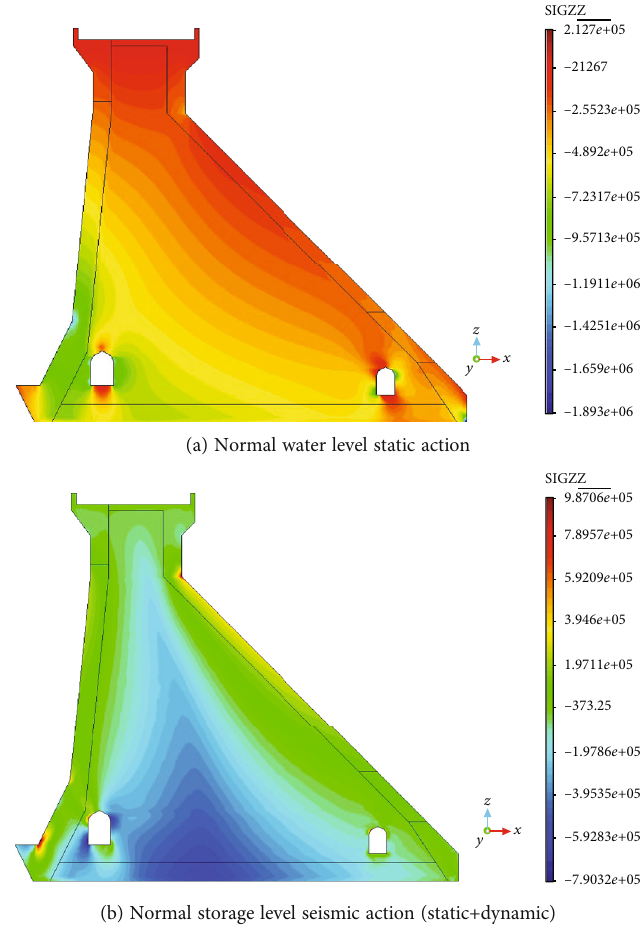
Figure 7: Vertical stress cloud of dam body in retaining dam section under di ff erent working conditions (Pa).